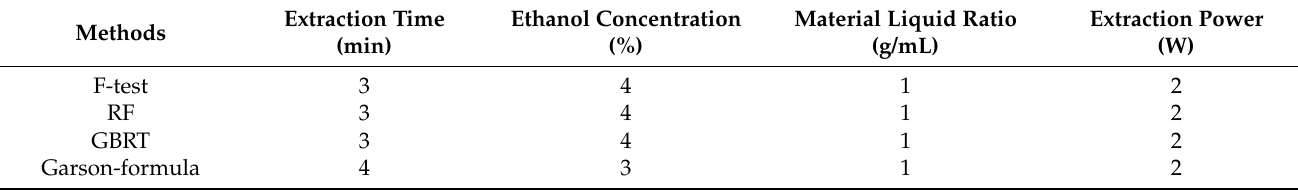
Figure 10. Importance ranking of single factor in RF. Table 6. Importance ranking of single factor in F-test, RF, GBRT, and Garson formula.